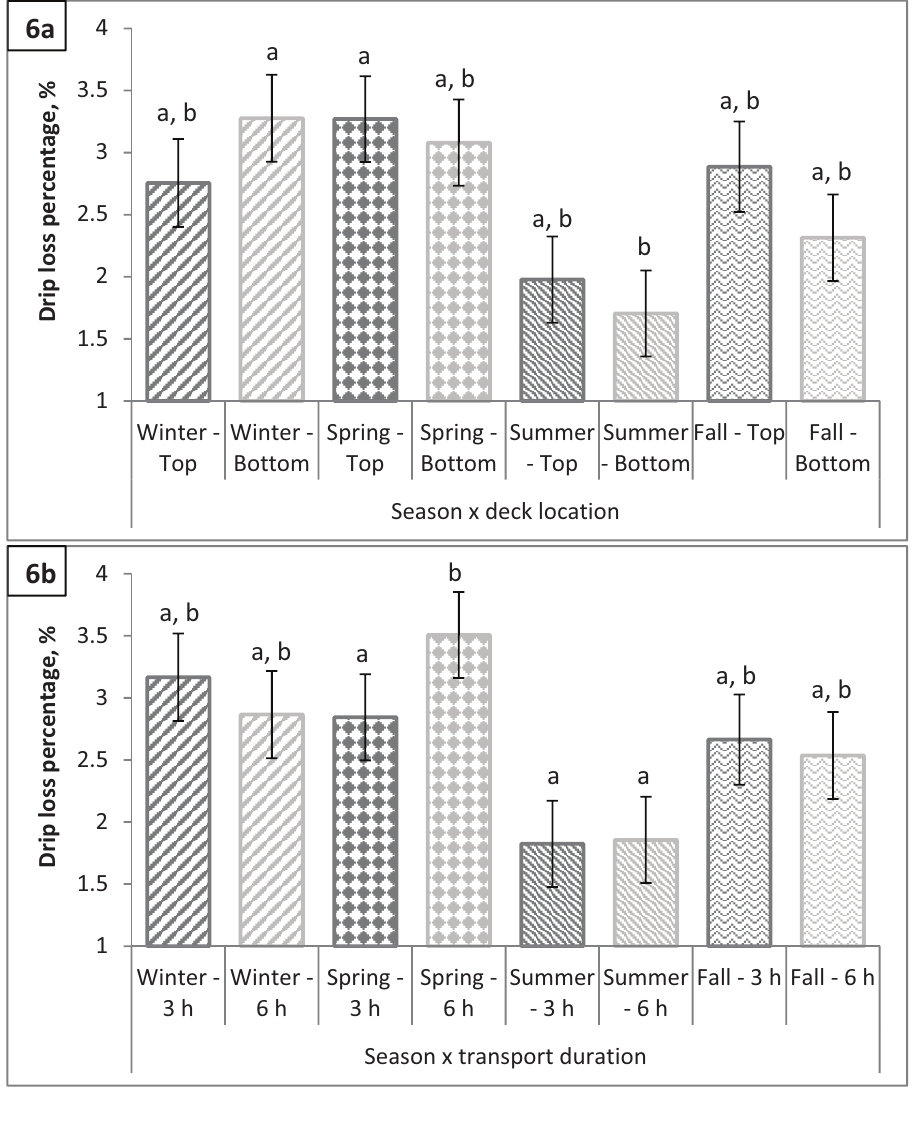
Figure 6. Drip loss percentage ( a ) by season × deck location (P = 0.0002) and ( b ) by season × transport duration (P = 0.0003). Values with different letters differ by P <